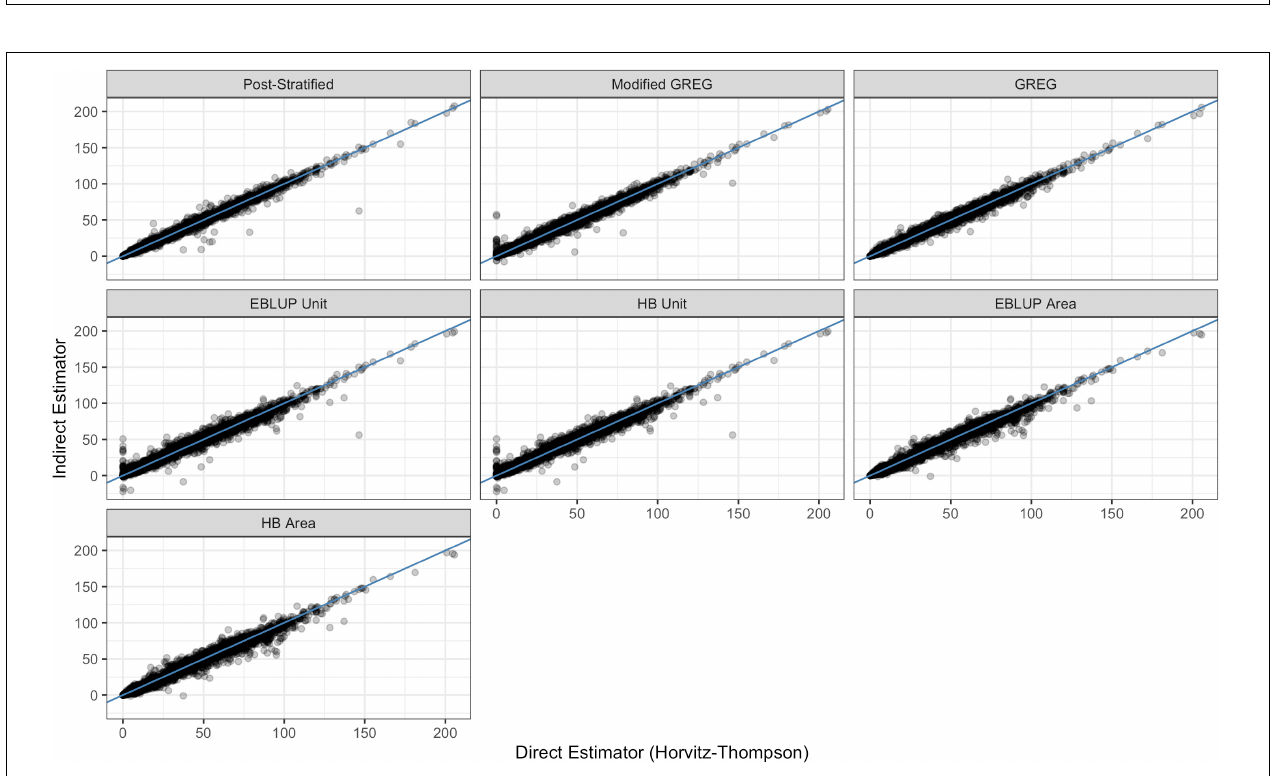
FIGURE 10 | Estimates of basal area (sqft) from each estimator compared to the Horvitz–Thompson for all counties in across the conterminous US.